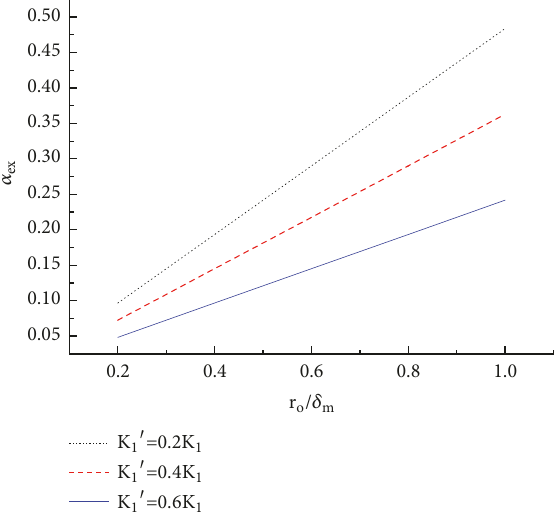
Figure 2: Variations of exchange-coupling coefficient 𝛼 ex with the ratio of r o to 𝛿 m for narrow